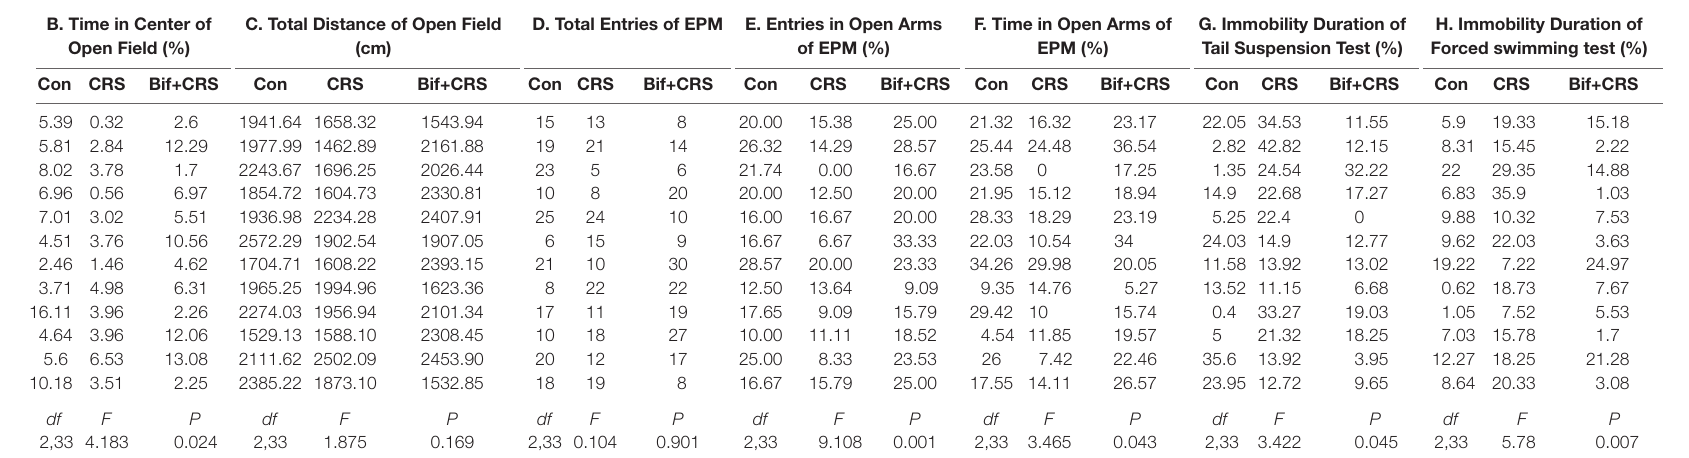
TABLE 2 | Anxiolytic and antidepressant effects of B. adolescentis in CRS